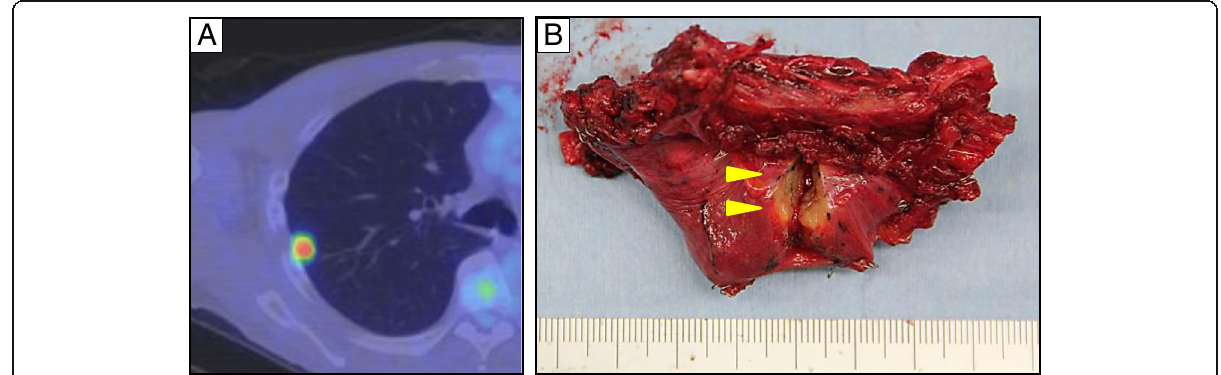
Fig. 3 PET-CT and specimen of right lung metastasis invading chest wall. a PET-CT showing the metastatic lesion. b Resected specimen showing the ashen lesion invading the chest wall (arrowheads)